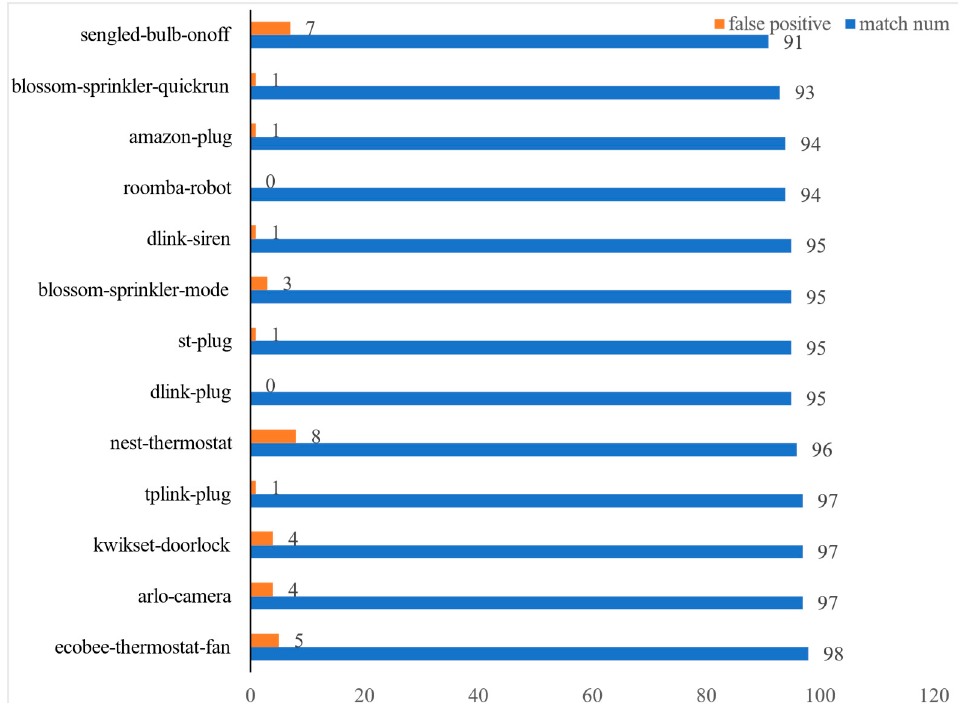
Figure 11. Max_time parameter experiment.